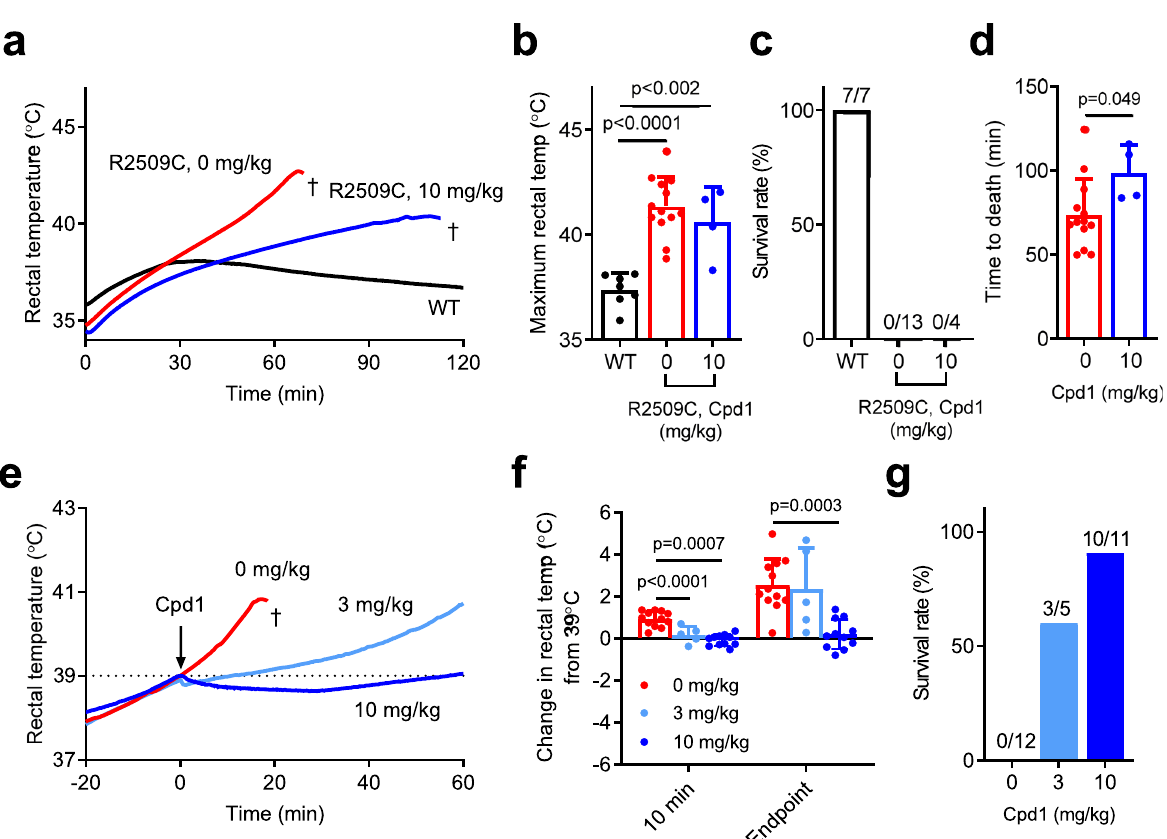
Fig. 5 In vivo heat stress challenge in WT and R2509C mice. Anesthetized mice were placed in a test chamber prewarmed at 35 °C. a – c Cpd1 (10 mg/kg) was administered 10 min before heat stress challenge. a Time course of the change of rectal temperature of mice. b Maximum rectal temperature. Data are shown as means ± SD (WT: n = 7; R2509C, 0 mg/kg: n = 13; R2509C, 10 mg/kg: n = 4) and were analyzed by one-way ANOVA with Tukey ’ s test. c Survival rate of mice 120 min after heat stress challenge. d Time to death from start of heat stress challenge. Data are shown as means ± SD (0 mg/kg: n = 13; 10 mg/kg: n = 4) and were analyzed by two-tailed unpaired t- test. e – g Rescue effects of Cpd1 on heat stroke in R2509C mice. e Time course of rectal temperature of mice. Cpd1 (0, 3, 10 mg/kg) was administered i.p. when their body temperature reached 39 °C (arrow). † , death by heat stroke. f Change in the rectal temperature from 39 °C at 10 min after the administration of Cpd1 or saline control and the endpoint (60 min after administration or just before death). Data are shown as means ± SD (0 mg/kg: n = 12; 3 mg/kg: n = 5; 10 mg/kg: n = 11) and were analyzed by one-way ANOVA